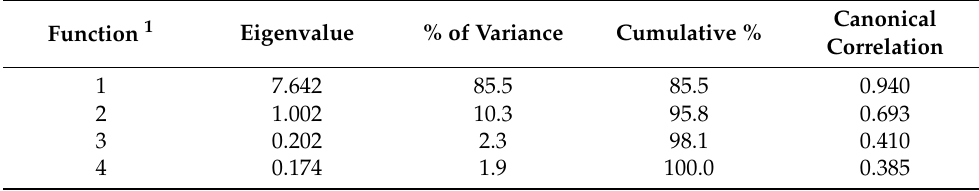
Table 3. Eigenvalues and % of variance for discriminant